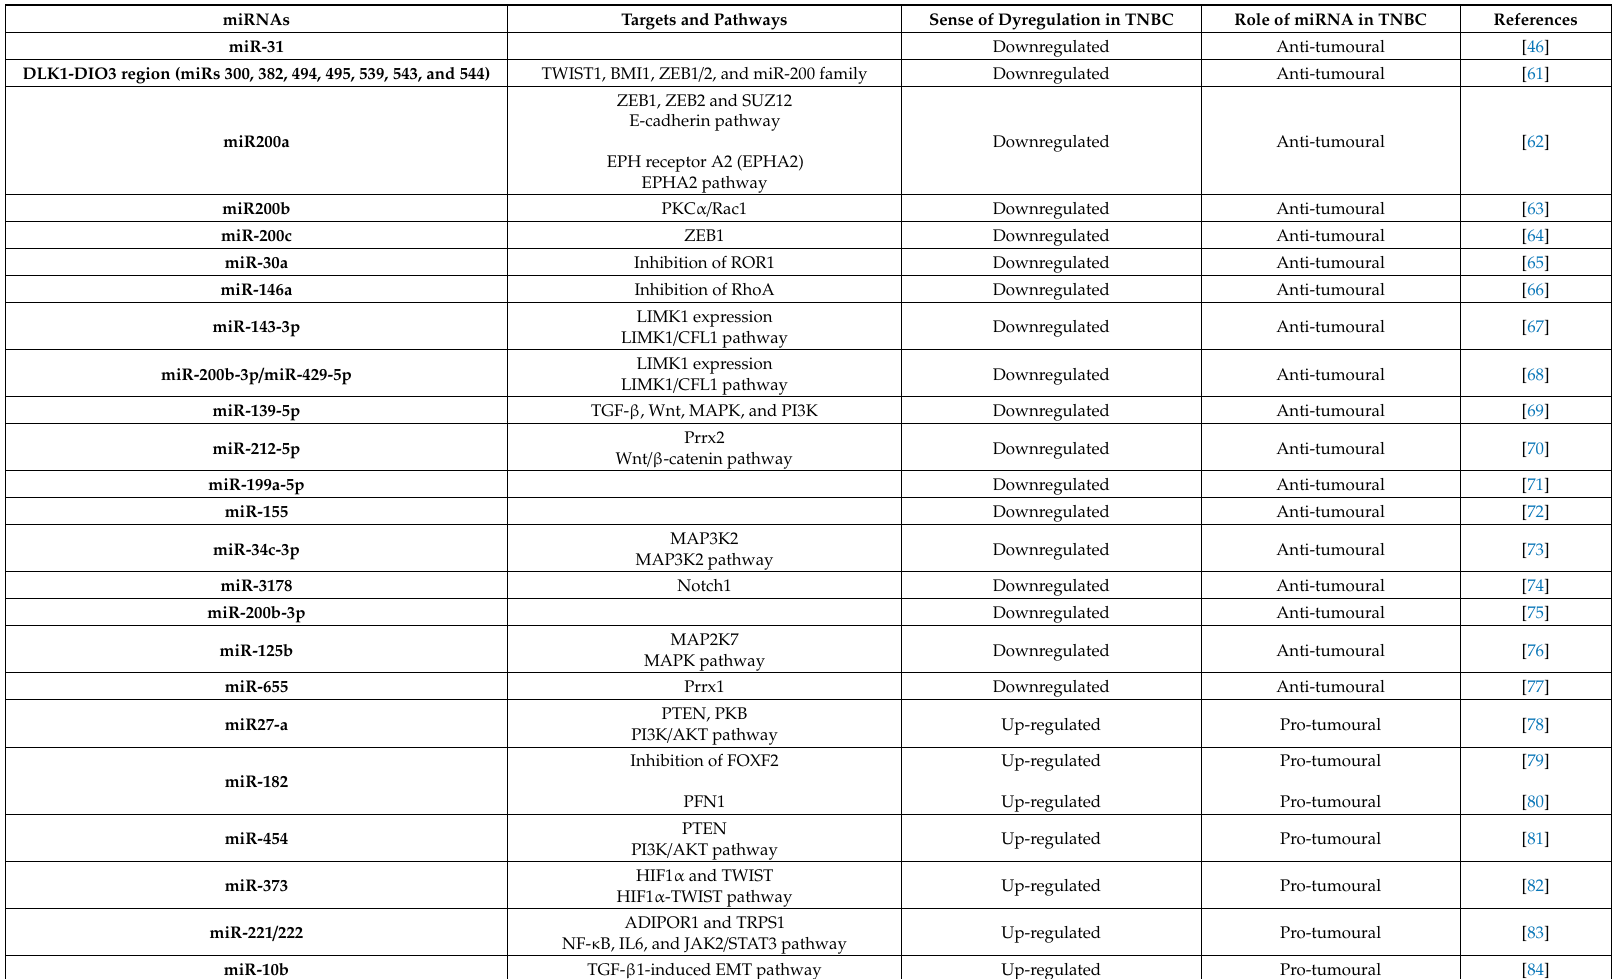
Table 2. Major miRNAs involved in EMT of